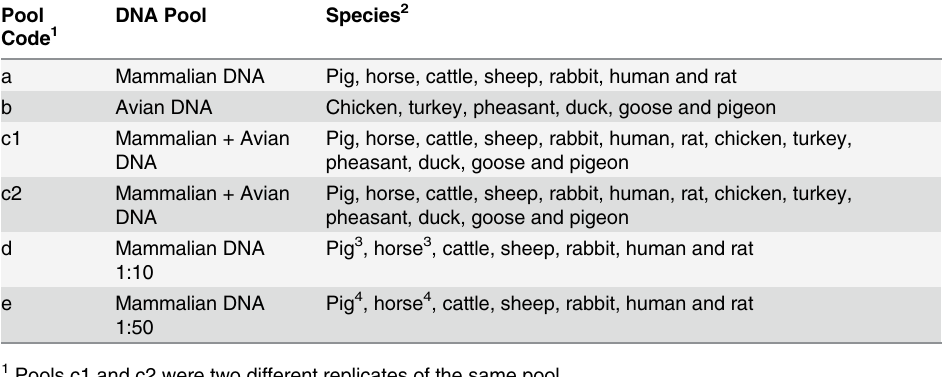
Table 1. Species composition of the different DNA pools used in PCR analyses.